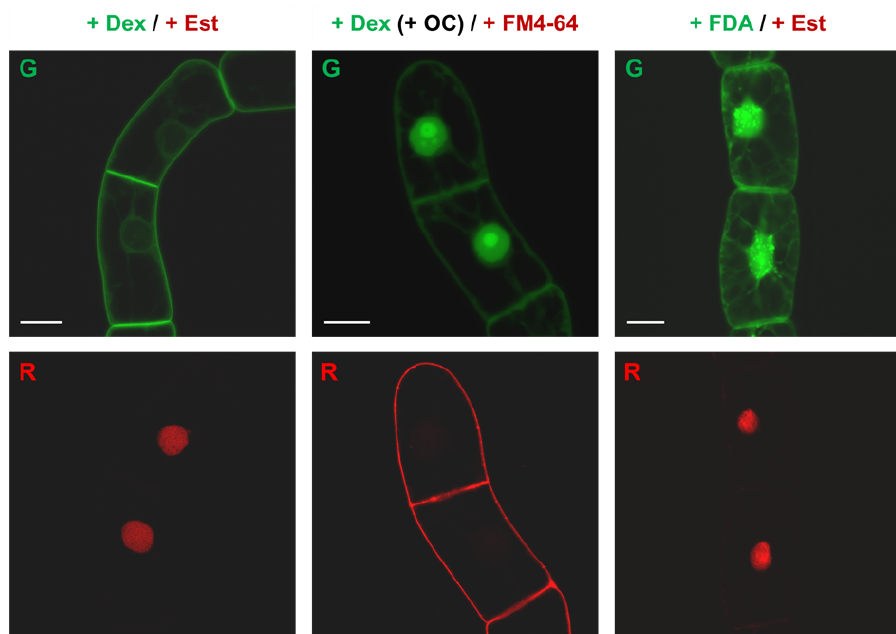
Figure 6. Expression of fusion proteins is tightly regulated by their specific inducers. No cross-induction of fusion gene expression was visible. Induction time for dexamethasone (Dex, 10 µM final) and estradiol (Est, 6 µM final) was 15 h in all experiments. + Dex / + Est: control experiments with both inducers with the GFP fusion protein targeted to the PM (G) and the mFRP fusion protein located in the nucleus (R). +Dex (+OC) / + FM4–64: Dex alone is only inducing the expression of the GFP fusion protein (G). The negative control with FM4-64 (5 µg/ml; membrane stain) shows no signals from the nucleus (R). For a better understanding, cells were treated with 50 µM oxoclomazone (OC) 3 h before induction, to indicate the position of the nucleus. Fluorescein diacetate ( FDA , 7.5 µM final) is used as negative control, also indicating that the cells were alive during the imaging process. G and R indicate the green and the red channel, respectively. Bars = 20 µm.